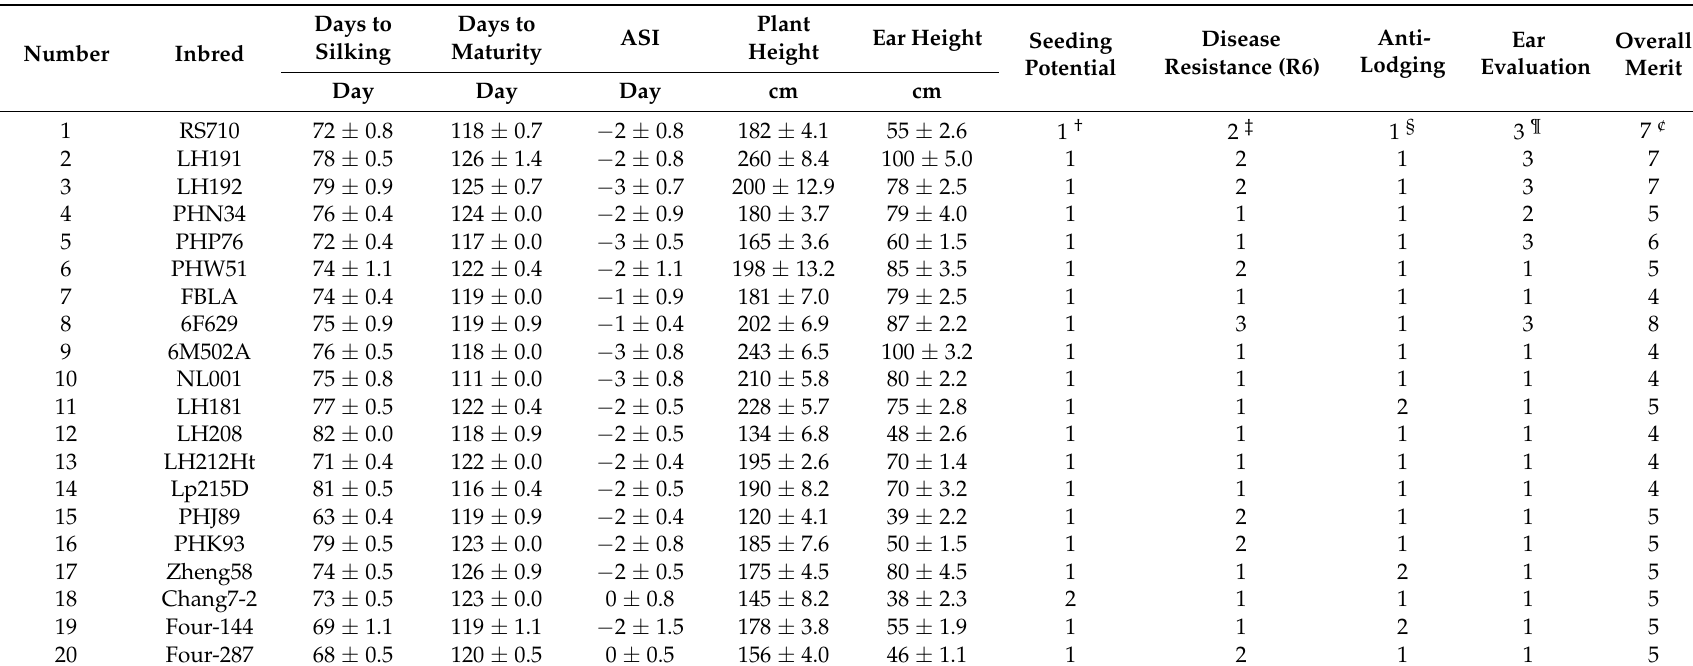
Table 4. Field characteristic and adaptability of the sixteen USA inbreds and four China inbreds in Hohhot. Values are the average ± 1 standard